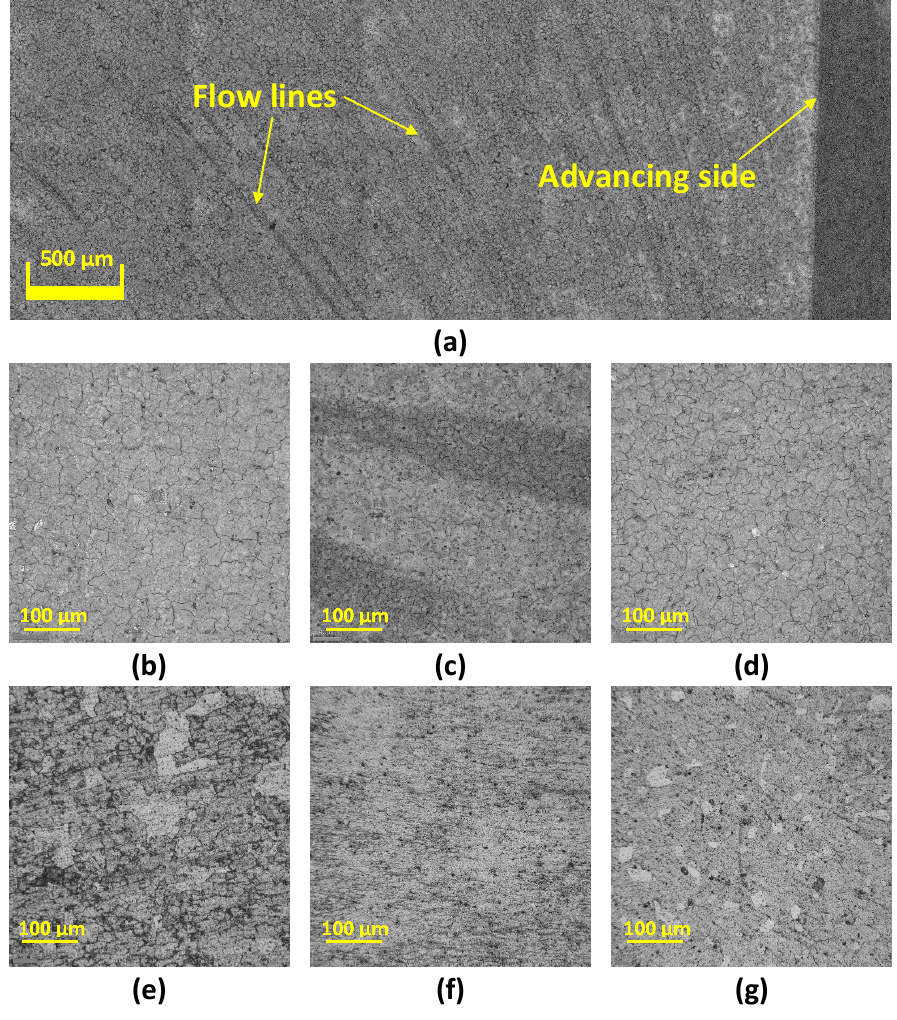
Figure 3. Optical microscope images ( a ) panoramic view of processed zone, ( b ) unprocessed Al metal, ( c ) FL-1, ( d ) FH-1, ( e ) FM-1, ( f ) FM-2, and ( g ) FM-3. Letters L, M and H represent 250, 500, and 1000 rpm, respectively. Digits 1, 2, and 3 designate 50, 100, and 150 mm / min, respectively).